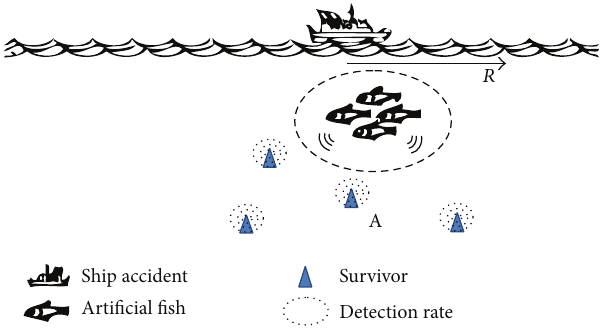
Figure 1: Task scenario